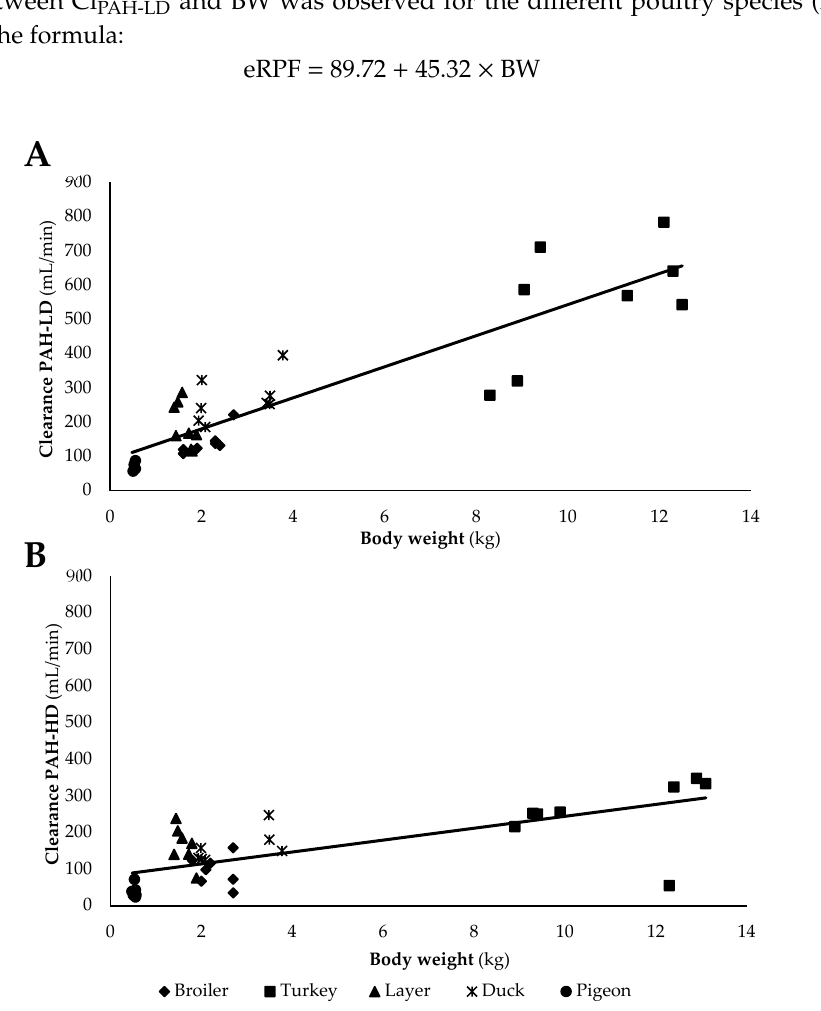
Figure 1. ( A ) Correlation between para-aminohippuric acid low dose (PAH-LD) clearance (mL/min) and body weight (kg). ( B ) Correlation between para-aminohippuric acid high dose (PAH-HD) clearance (mL/min) and body weight (kg) in different poultry species (broiler, turkey, layer, duck, and pigeon) ( n = 8). The PAH-LD clearance is an estimate of the effective renal plasma flow, and the PAH-HD clearance is an estimate of tubular secretion.